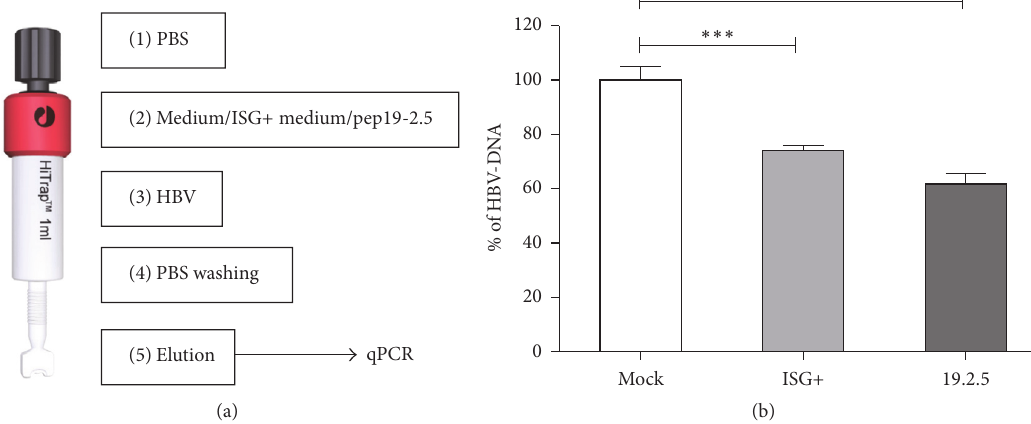
Figure 4: IFN- 𝛼 induced products compete with HBV for binding to heparin column. (a) Heparin columns were washed with PBS and then applied with differentiated HepaRG cell culture medium (mock) or IFN- 𝛼 treated differentiated HepaRG cell culture medium (ISG+) or the entry inhibitor Pep19-2.5. Then columns were applied with PBS containing HBV. After washing, HBV was eluted by elution buffer. (b) HBV amount from different elutions were analyzed by HBV-DNA